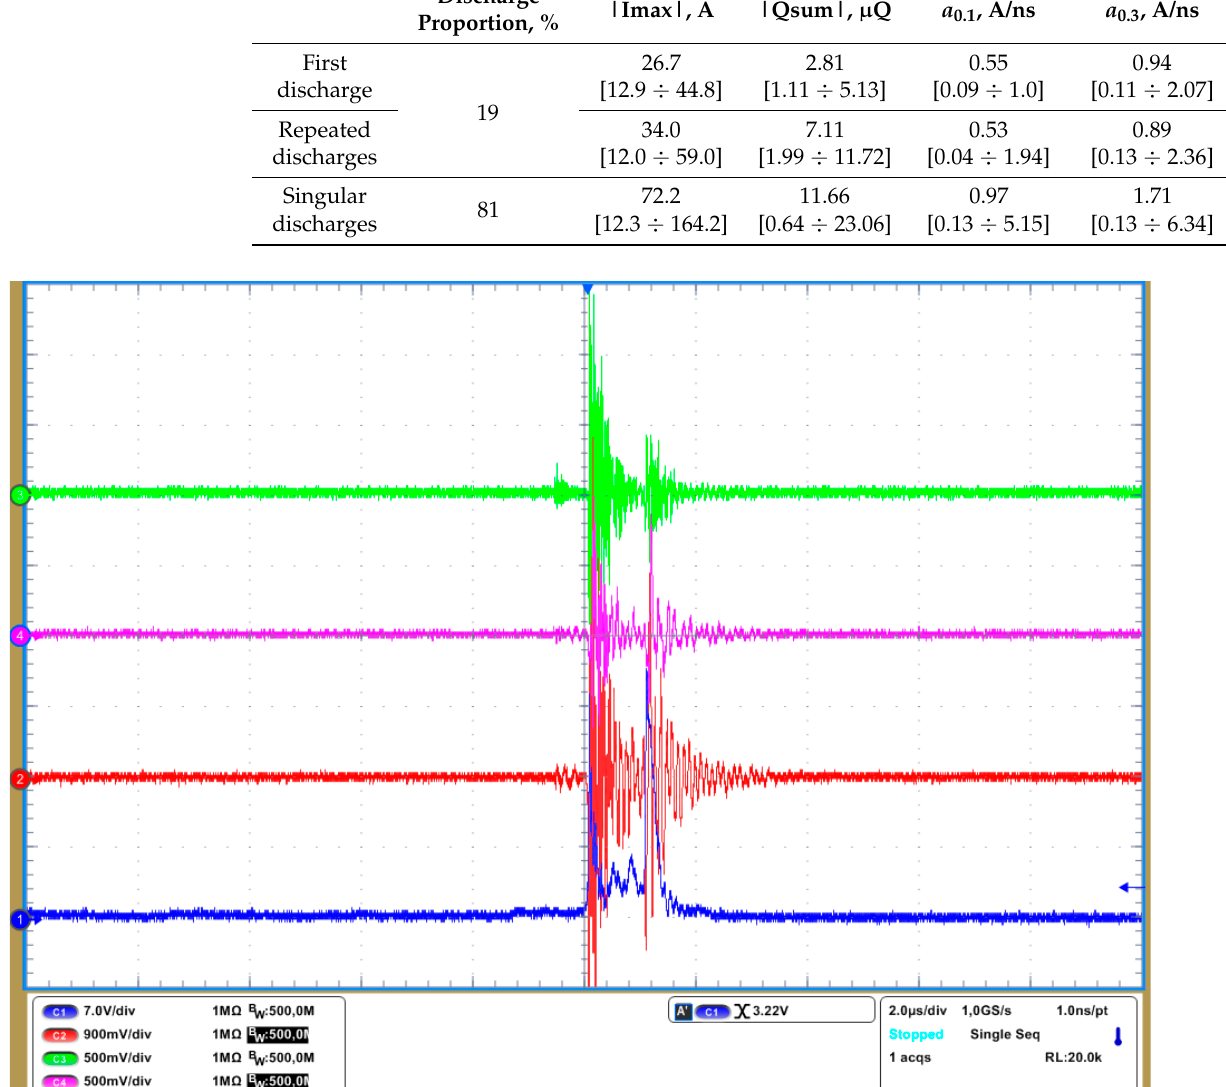
Figure 7. Characteristic dynamics of single discharge formation from an artificial thunderstorm cell of positive polarity with the participation of lower and upper groups of model hydrometeors (frame size 75 × 75 cm, frame duration 1.5 μ s, pause between frames 0.1 μ s).